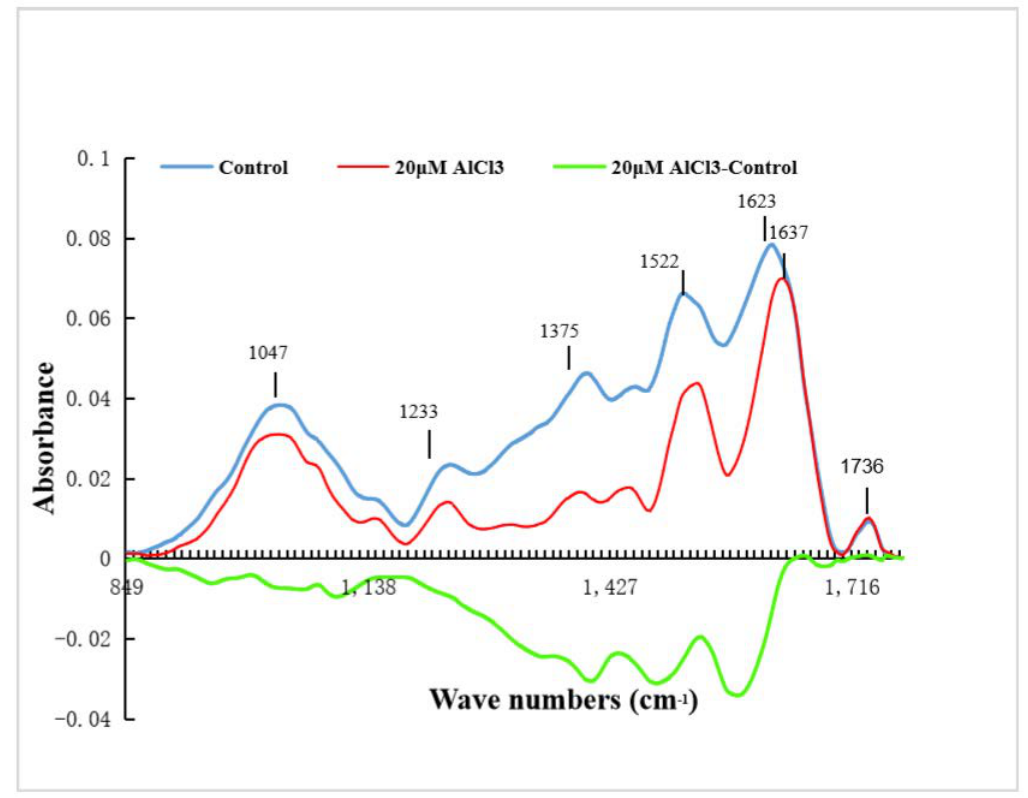
Figure 7. FTIR spectra from the tip of pollen tubes of M. domestica. FTIR spectra from the tip regions of control pollen tubes ( blue line ), 20 µ M AlCl 3 treated pollen tubes ( red line ), and the FTIR differential spectrum generated by digital subtraction of the red spectra from blue spectra ( green line